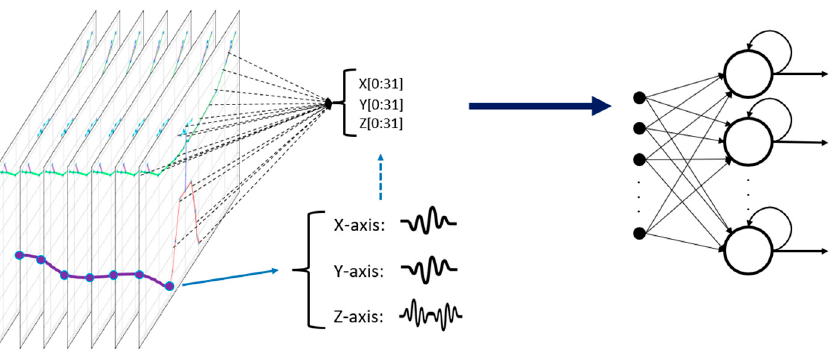
Figure 10. Frame sequence representing time series data for three axes of each joint.